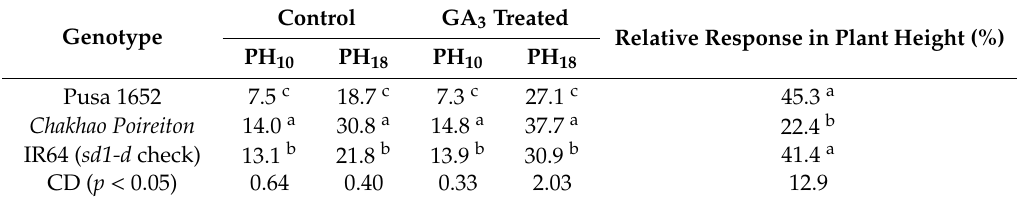
Table 1. Response of plant height of genotypes Pusa 1652, Chakhao Poireiton and IR64 to external application of gibberellic acid (GA 3 ) at seedling